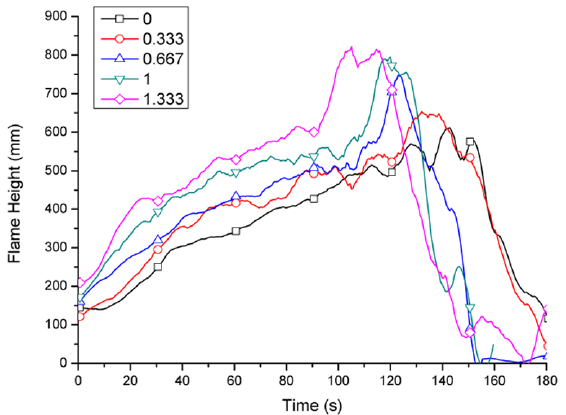
Fig. 5. 20 points smoothed average flame height of each condition as a function of time (The symbols on each curve are only for visual identification